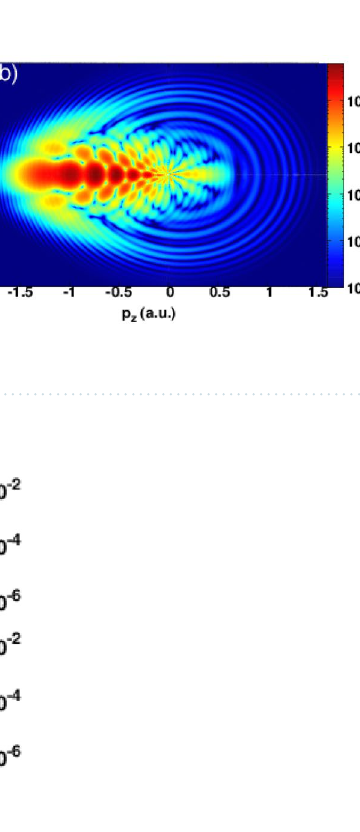
Figure 5. Photoelectron momentum distributions corresponding to the ionization of hydrogen induced by a strong laser pulse with different number of optical cycles N. ( a ) N = 1; ( b ) N = 2; ( c ) N = 3 ; ( d ) N = 8. The laser intensity and the carrier envelope phase are the same for all panels and are fixed respectively at 1 × 10 14 W / cm 2 and ϕ cep = 0 . All the heat maps in this figure were generated using Gnuplot software (www. gnupl ot. info), version [5.4] for Unix